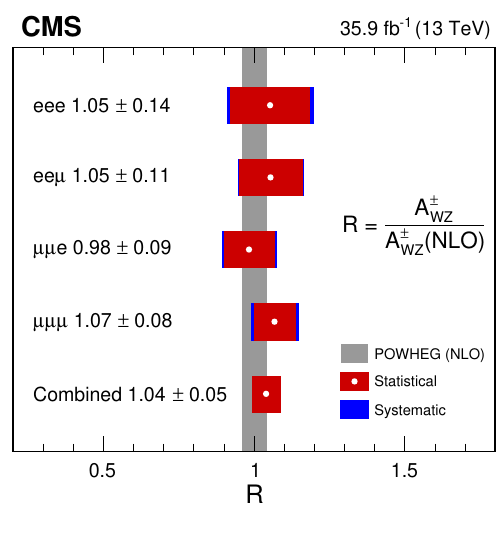
Figure 7 . Measured ratio of cross sections for the two charge channels for each of the (cid:13)avour categories and their combination. Values are normalized to the NLO prediction obtained with powheg . Coloured bands for each of the points include both systematic and statistical uncertain- ties. Shaded bands correspond to the MC prediction from the nominal powheg sample and its associated